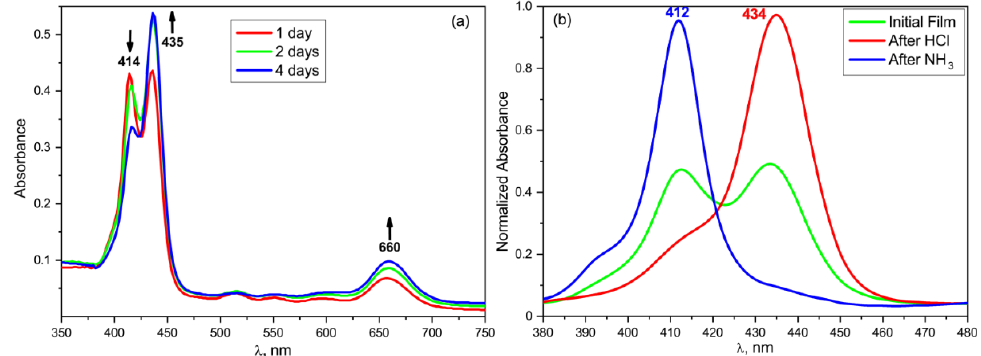
Figure 13. Changes in the absorption spectra of the TPP-doped film with time during storage ( a ) and during sequential exposure to ammonia and hydrogen chloride vapor ( b ).